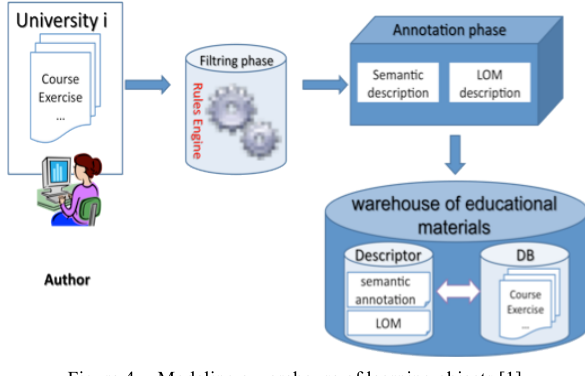
Figure 4. Modeling a warehouse of learning objects [1].